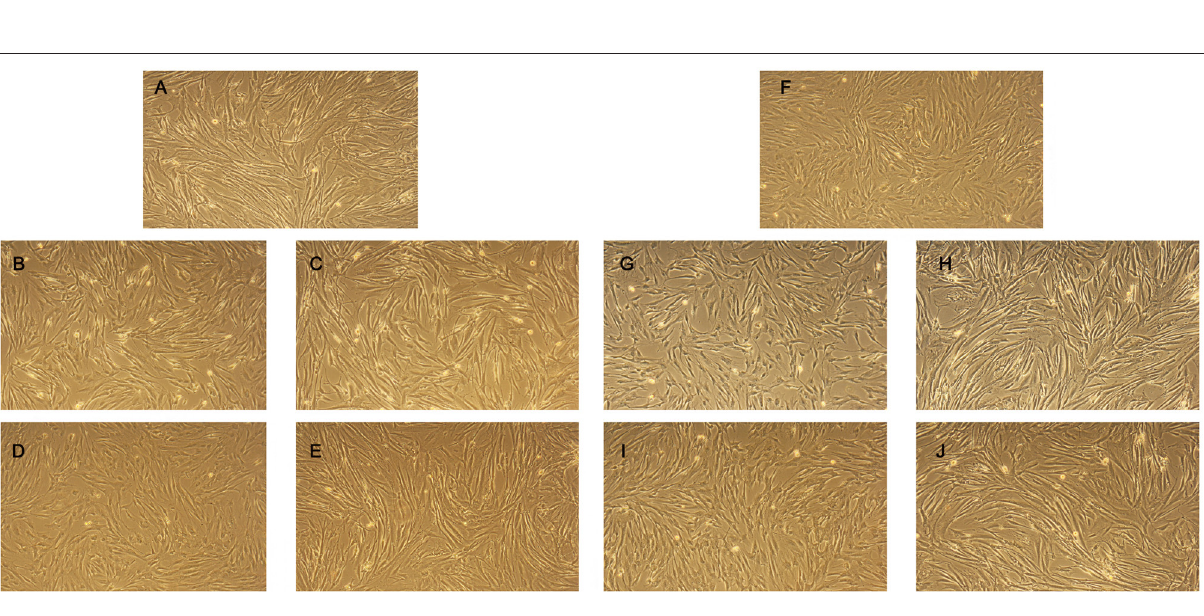
Frontiers in Immunology |